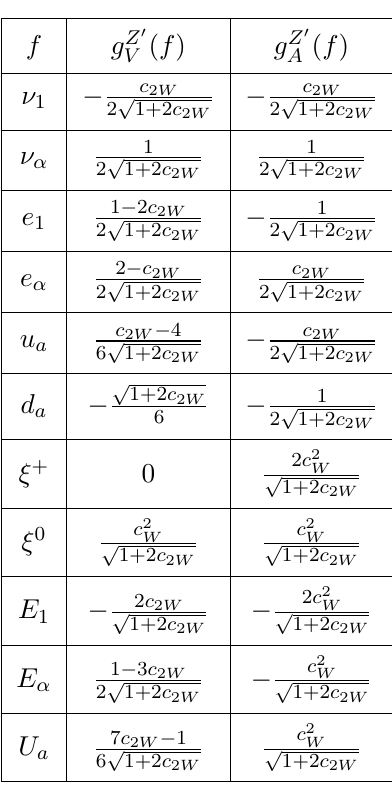
Table 4 . The couplings of Z 0 with